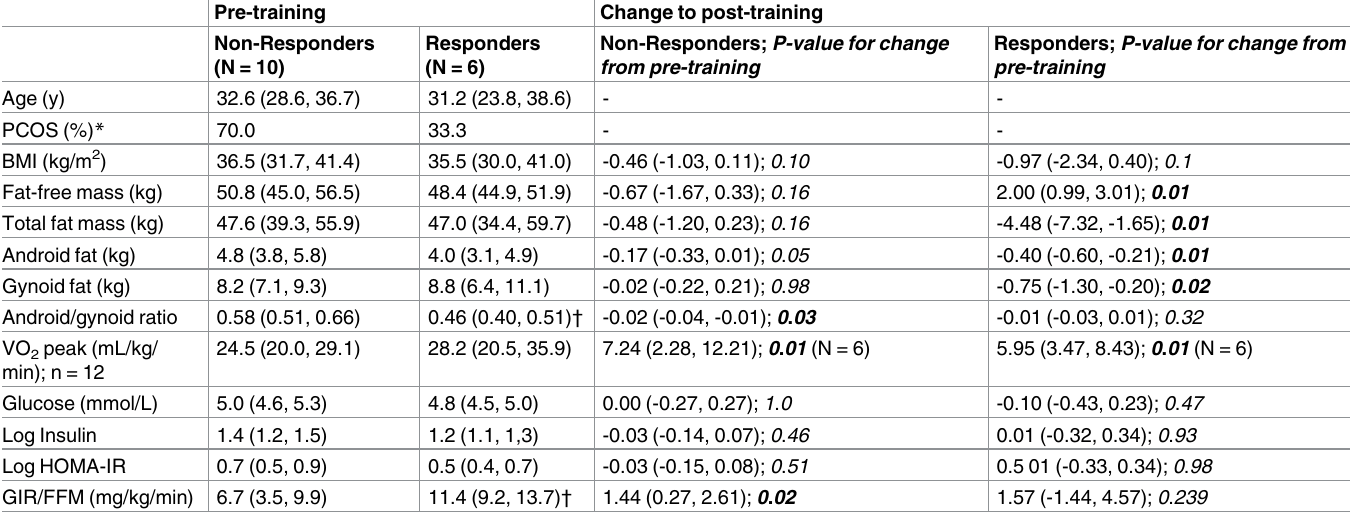
Table 1. Comparison of pre-training and post-training values for body composition and cardiometabolic parameters according to exercise responsiveness.